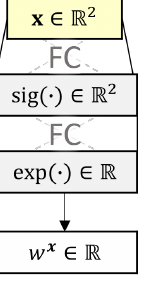
Figure 3. Architecture of w x